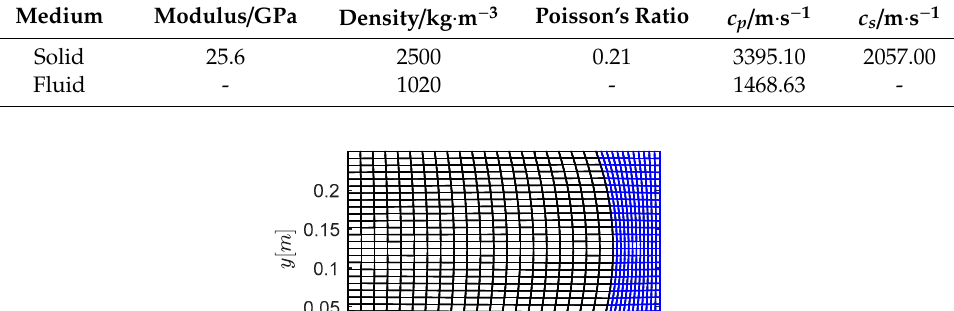
Table 4. Parameters of the curved regions.